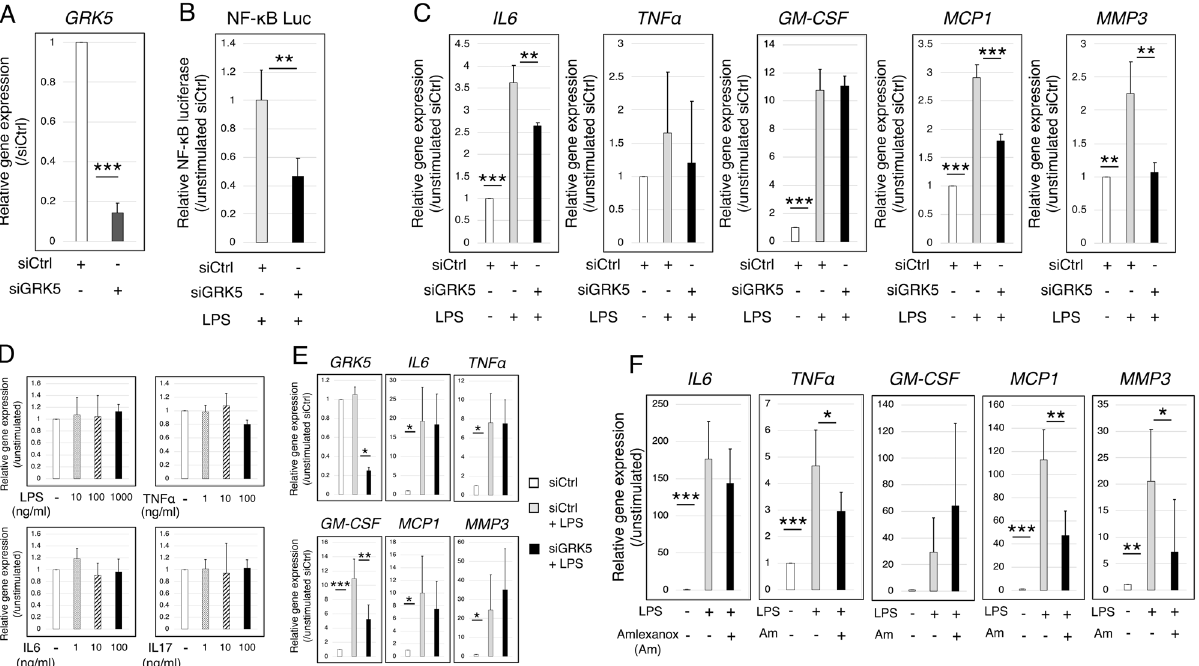
Figure 2. Effects of GRK5 knockdown by siRNA on NF-κB transcriptional activation and the expression of inflammatory genes in the human synovial SW982 cell line and human primary RA synovial cells. ( A ) Efficiency of GRK5 knockdown in SW982 cells transfected with small interfering RNA (siRNA)-targeting GRK5 (siGRK5). Values are means ± SD (n = 3). *** P < 0.001 versus siRNA for control (siCtrl). ( B ) NF-κB transcriptional activation in siGRK5-transfected SW982 cells. Values are means ± SD (n = 4). ** P < 0.01 versus siCtrl. ( C ) Changes in gene expressions in response to LPS stimulation in siGRK5-transfected SW982 cells. Values are means ± SD (n = 3). ** P < 0.01; *** P < 0.001. ( D ) Effect of various inflammatory stimulation on GRK5 gene expression in human primary RA synovial cells. Values are means ± SD (n = 3). ( E ) Efficiency of GRK5 knockdown in human primary RA synovial cells transfected with siGRK5. Values are means ± SD (n = 4). ** P < 0.01. ( F ) Efficiency of GRK5 inhibition with Amlexanox. Values are means ± SD (n = 4). * P < 0.05; ** P <